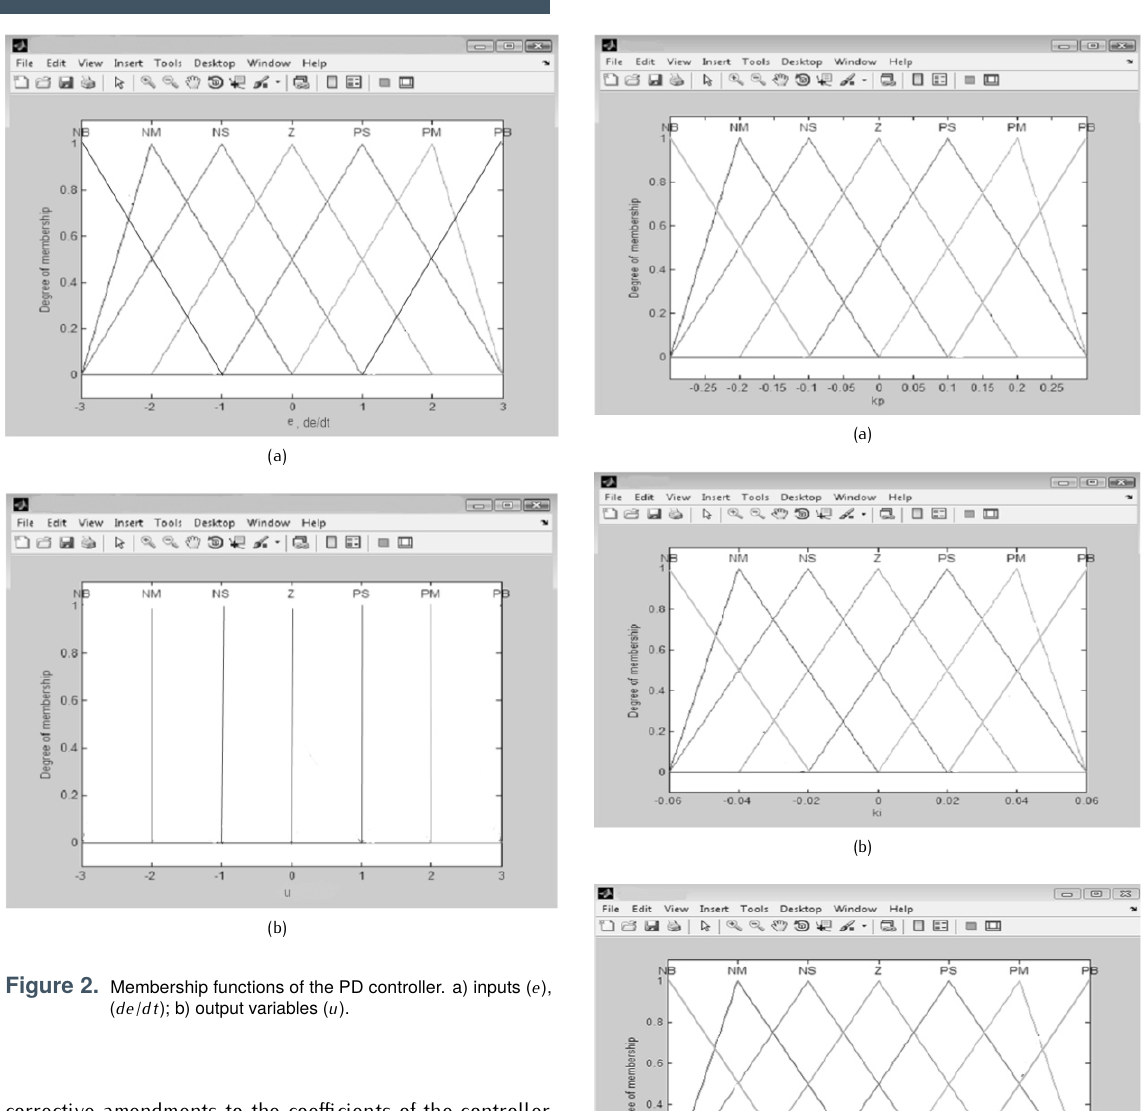
corrective amendments to the coefficients of the controller settings ( k p , k I , k D ), as afunction of the current value of the parameter adjustment.